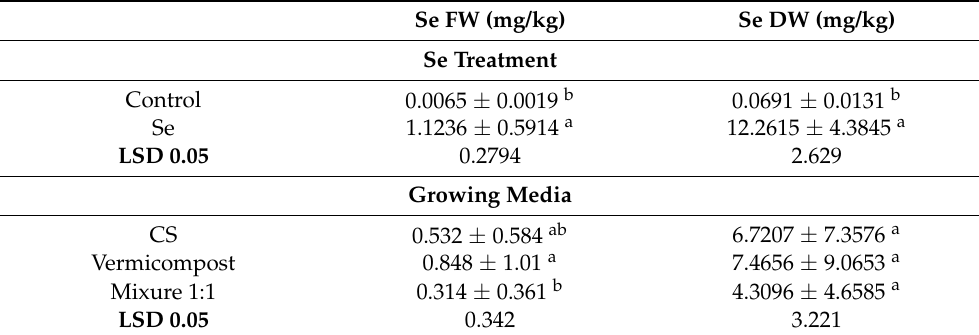
Table 4. Mean values ± the standard deviations of the Se contents in the fresh weight (FW) and dry weight (DW) of the lamb’s lettuce tissue. The different letters represent the significance of the differences at the α = 0.05 level.